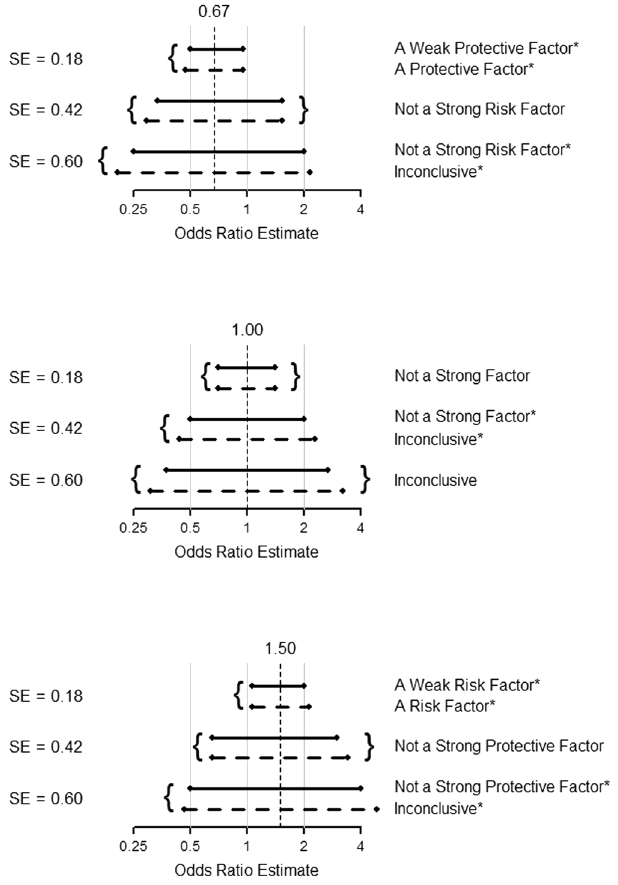
Figure 2. A comparison between the five-region confidence intervals (solid lines) and the classical confidence intervals (dashed